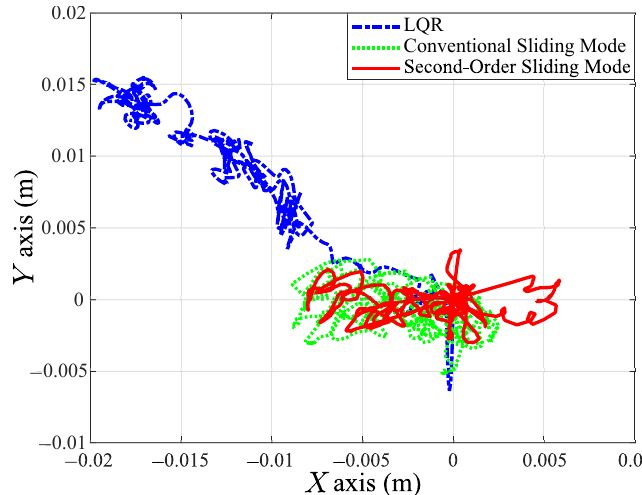
Figure 19. The experimental results compare the robot’s trajectory in the X - Y plane.